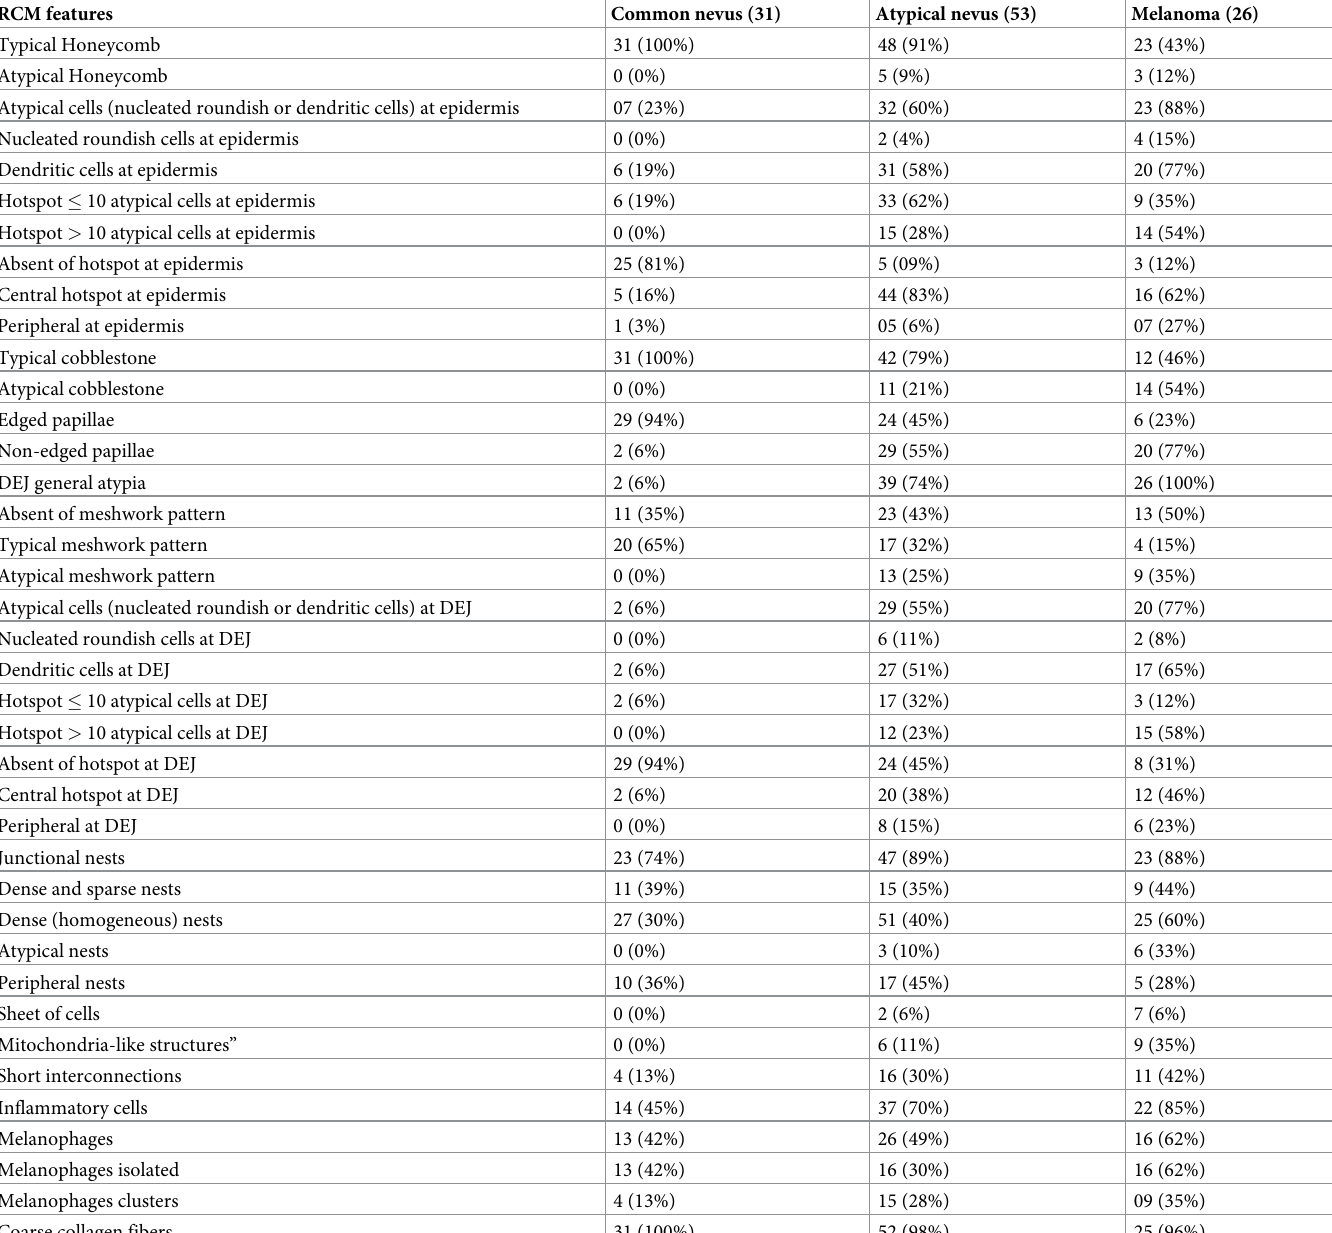
Table 2. Frequency of RCM features in common nevi, atypical nevi and melanomas. RCM